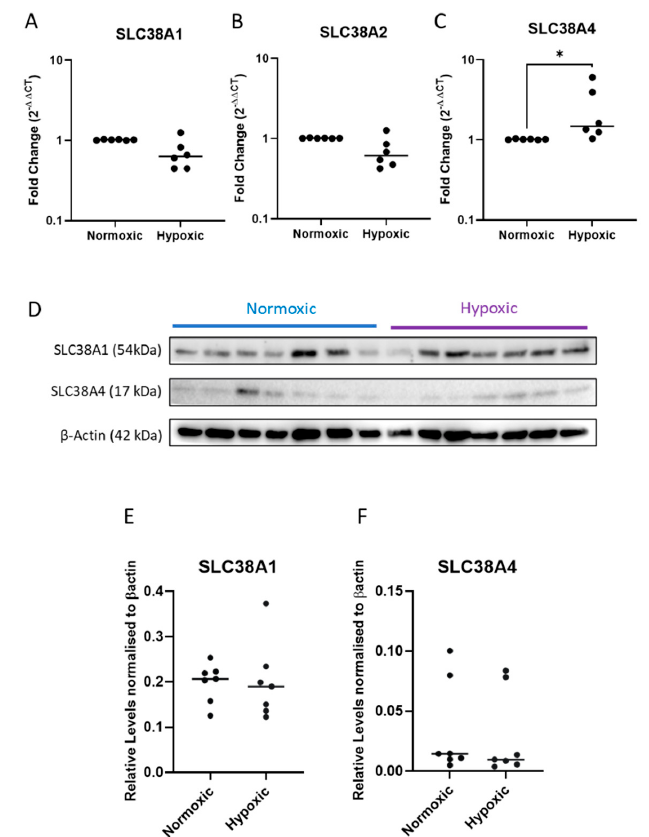
Figure 4. IUGR relevant hypoxic stress conditions induced SLC38A4 expression at the gene level, however, protein expression remains unaffected in vitro trophoblast cultures. Compared to normoxic controls, hypoxic trophoblasts showed insignificant changes to the expressions of SLC38A1 ( A ) and SLC38A2 ( B ). SLC38A4 expression was significantly upregulated under hypoxic conditions ( C ) (n = 6/condition) (assessed via qPCR). Western blots ( D ) showed patient derived var- iations in response to hypoxia, which did not consistently alter the expressions of SLC38A1 ( E ) or SLC38A4 ( F ) (n = 7/condition). Results are displayed as medians * p < 0.05 (the paired t -test was used for qPCR analysis, and the Wilcoxon nonparametric test was used for Western blot analysis). These results suggest that short-term changes in nutrient composition in media may be a more dominant factor affecting gene expression of these transporters than hypoxia. Nonetheless, SLC38A4 expression was more sensitive to and significantly upregulated in response to glucose and oxygen deprivation stresses. However, gene changes do not re- flect protein levels, which may be more tightly regulated or compensated in trophoblasts. 3. Discussion Amino acid transport across the placenta and supply to the fetus are crucial for healthy development. System A sodium-coupled transporters are key to partitioning of neutral amino acids to the fetus. However, genetic targeting of these transporters has also revealed their role in supporting proliferation and cellular composition of the developing rodent placentas [4]. In human preeclampsia and IUGR, altered transporter expression and function reduces cord plasma amino acid concentrations and delivery to the fetus [6,16]. Yet, it is unclear whether the changes in transporters precede placental dysfunction and contribute to the condition or if they are impacted because of suboptimal cellular